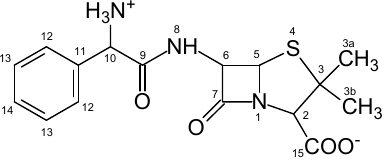
Figure 1. Ampicillin molecule in the zwitterionic form.